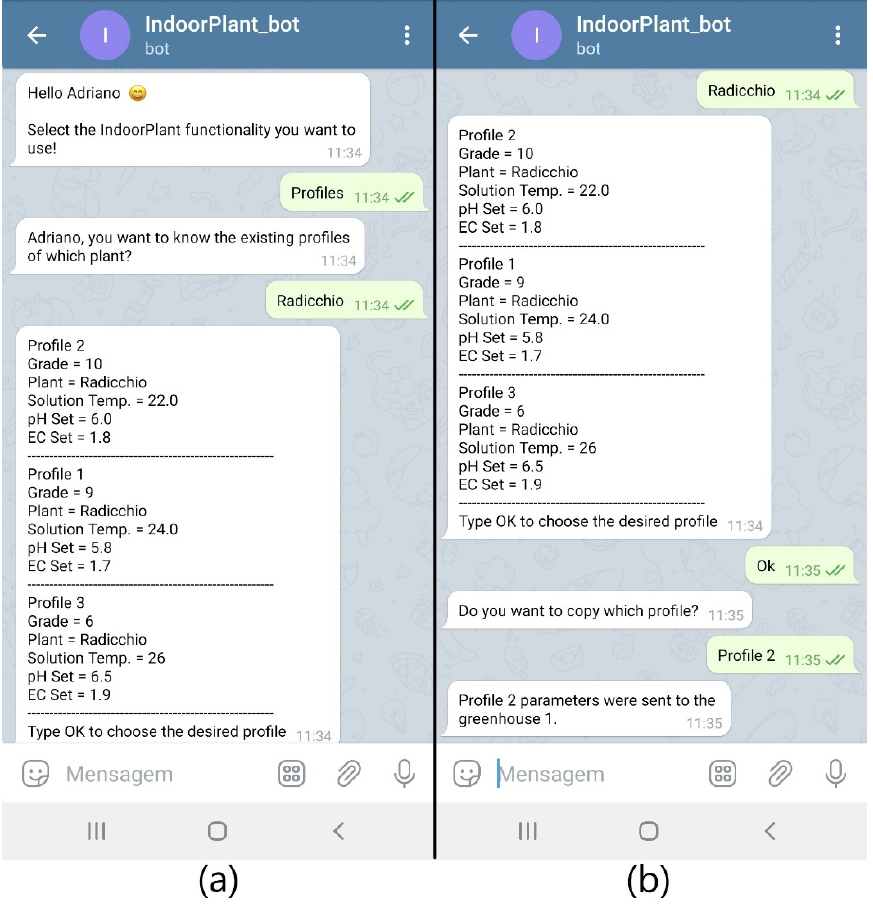
Figure 8. Existing ( a ) and chosen ( b ) radicchio profiles.